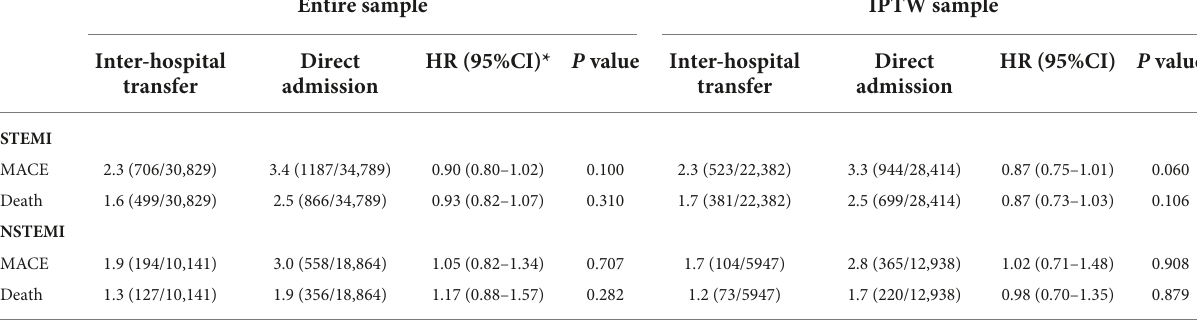
TABLE 3 The association between in-hospital outcomes and inter-hospital transfer vs. direct admission in patients with STEMI and NSTEMI. Entire